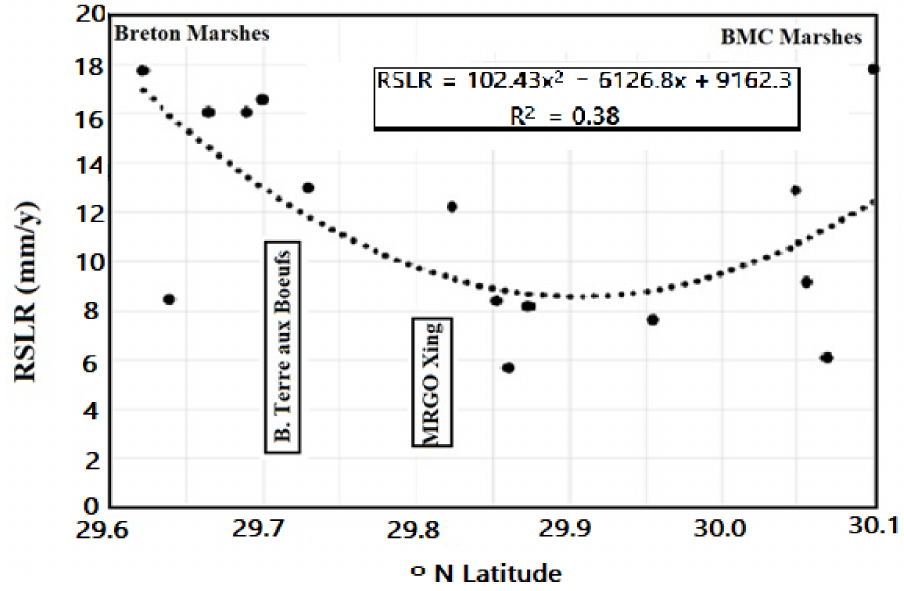
Figure 13. Spatial distribution with latitude of decadal mean rates (2008–2018) of Relative Sea Level Rise (RSLR) at CRMS sites along CRMS Transect (Figure 3, Table S3).